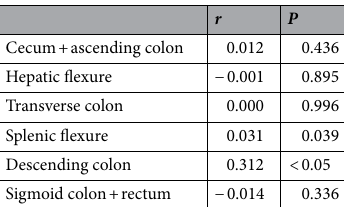
Table 5. Correlation between adenoma detection and luminal distention in different